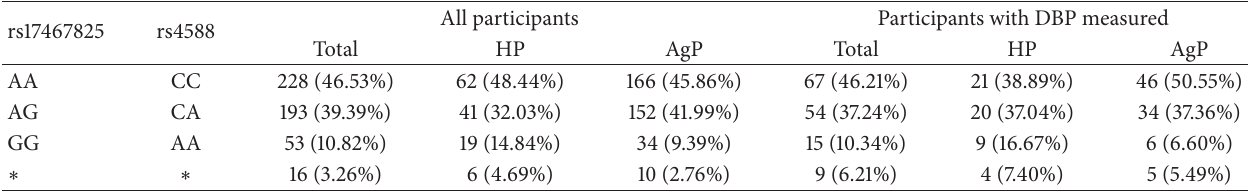
Table 4: Combined genotype distributions in different groups a